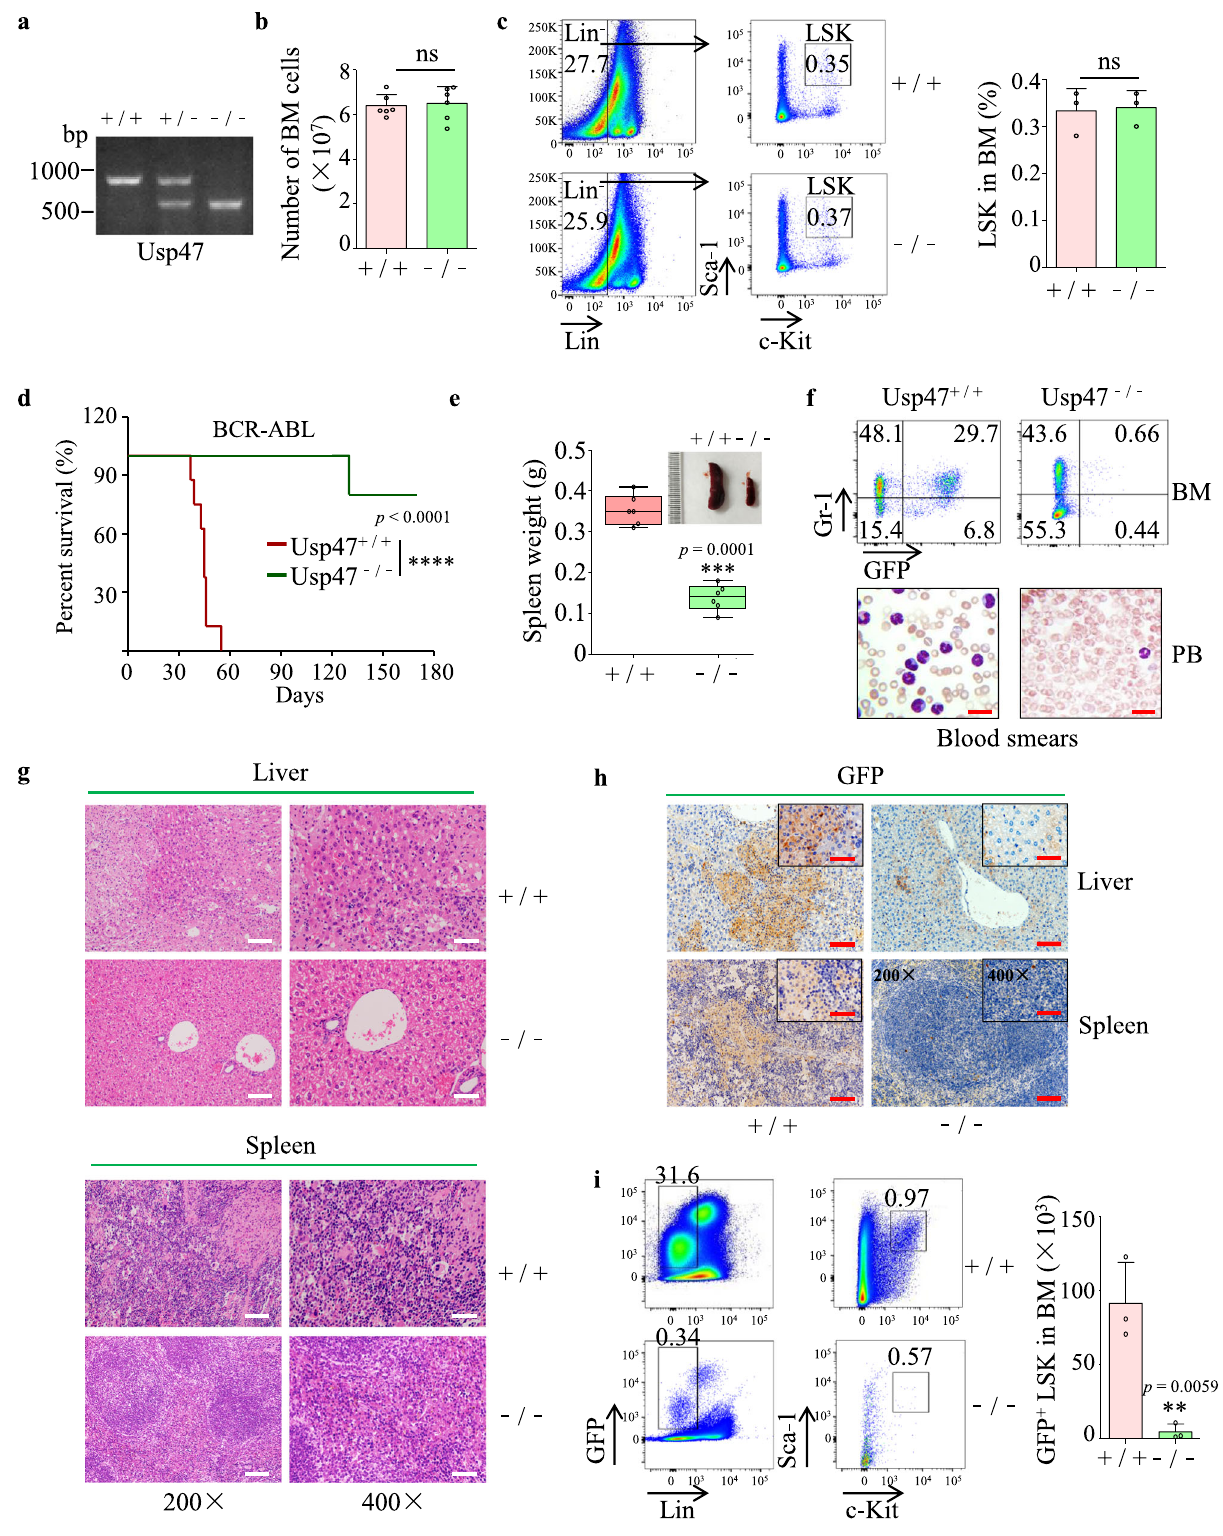
was detected in the liver and spleen of the Usp47 + / + mice (Fig. 3h). Furthermore, the number of CML leukemia stem/pro- genitor cells (GFP + LSK cells) in the Usp47 − / − group is sig- ni fi cantly decreased compared with the Usp47 + / + group (Fig. 3i). These data demonstrate that USP47 plays a vital role in the pathogenesis of BCR-ABL-induced